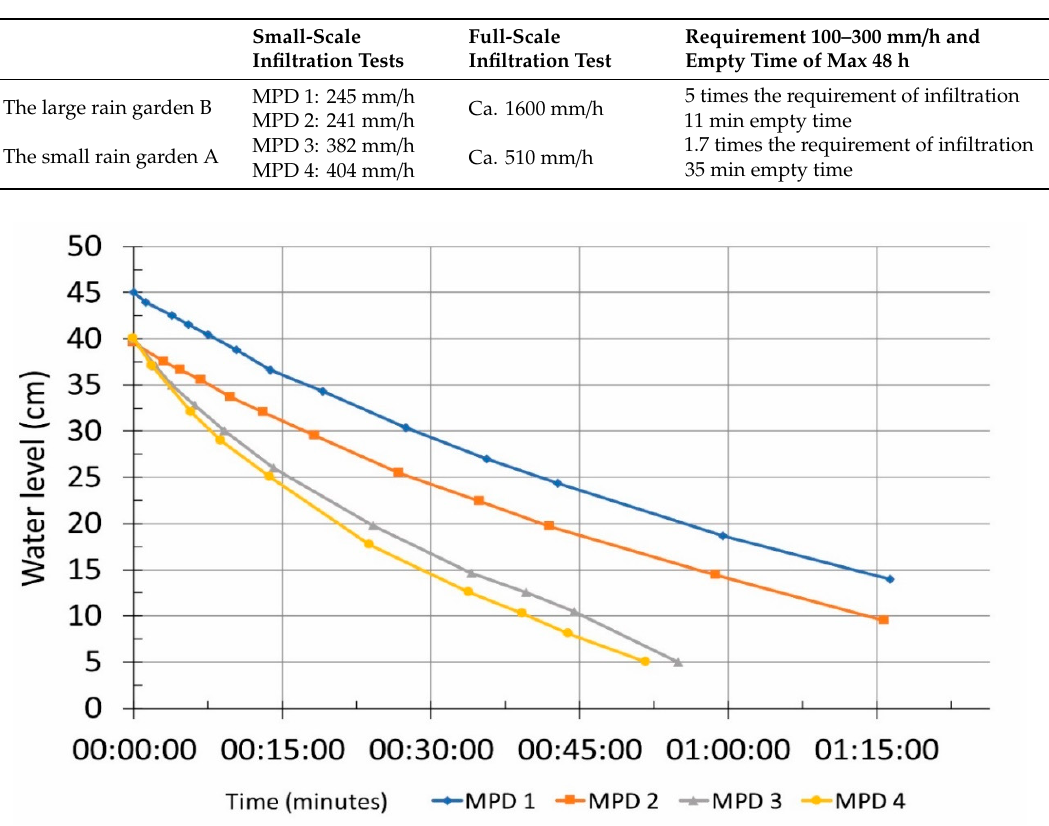
Table 2. The results of the small-scale and full-scale infiltration test show di ff erent infiltration capacity for the two rain gardens, compartment A and B, tested in this study. Results compared to international guidelines [41–45].